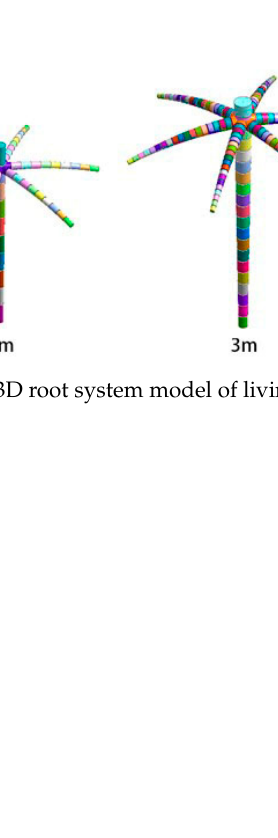
Figure 4. Variable cross-section groups.